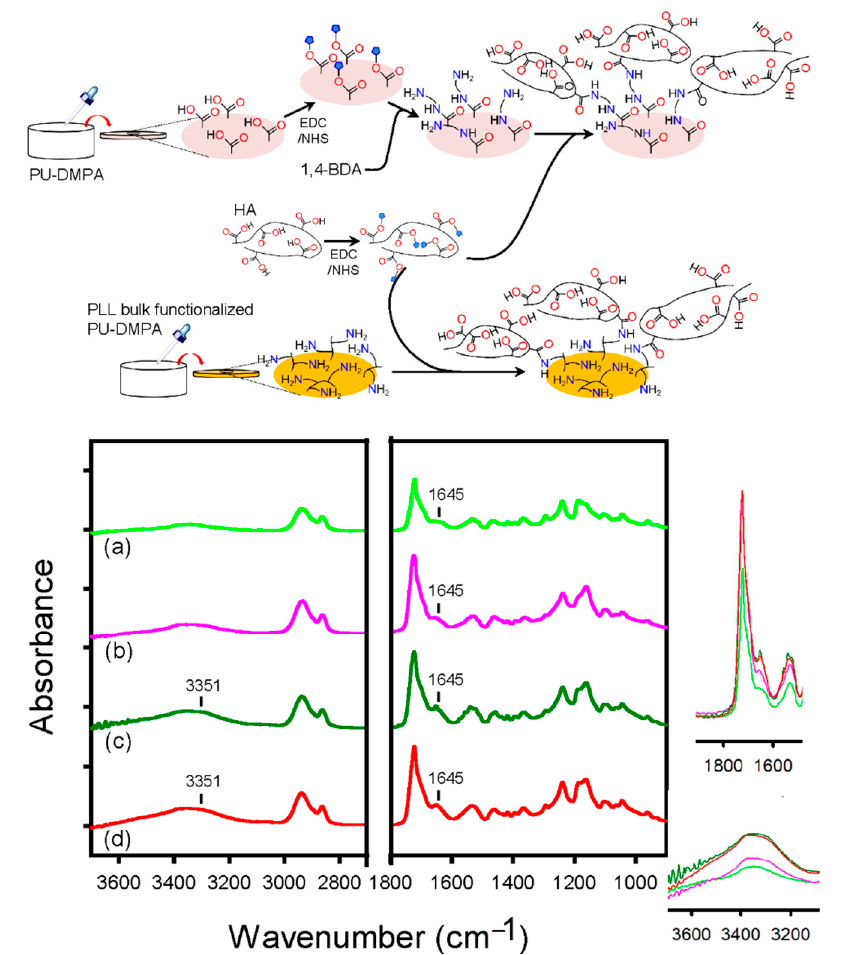
Figure 9. Top: schematic of the amino functionalization of the PU-DMPA cast film and bulk polymer solution by 1,4-BDA and PLL, respectively, followed by the incorporation of HA. Bottom: ATR-FTIR spectra of the BDA-modified PU-DMPA ( a ), the PLL-modified PU-DMPA ( b ), the HA-modified PU-DMPA-BDA ( c ), and the HA-modified PU-DMPA-PLL ( d ). The HA-modified surface of the PU-DMPA-BDA and the PU-DMPA-PLL films were subjected to platelet adhesion tests with the PU-DMPA, PU-DMPA-BDA, and PU-DMPA- PLL films serving as controls. A material that has antithrombotic ability might be applied in the development of blood contact devices. Figure 10 shows the SEM images of the mor- phology of platelets adhered on the five surfaces. SEM showed less platelet adhesion on the surface of the PU-DMPA-BDA-HA and the PU-DMPA-PLL-HA films. The attached platelets, if any, had round shapes. The PU-DMPA-PLL-HA membrane even had less platelet adhesion than the PU-DMPA-BDA-HA. The results may be attributed to more amino groups in PLL and hence more HA conjugation on the PU-DMPA-PLL. Despite the limited number of carboxyl groups in the PU-DMPA backbone, the number of available amino groups was multiplied with the use of PLL as a linker. Obvious platelet adhesion on the PU-DMPA-BDA and the PU-DMPA-PLL was noted possibly due to the positive charge of amino groups. Interestingly, the PU-DMPA surface also displayed only few ad- hered platelets, perhaps due to the negative charged of the carboxyl groups. Hong et al. also found reduced platelet adhesion on the surface of their poly(ester urethane) bearing carboxyl groups [18]. This contradicts the finding in an earlier study; however, note that hydroxytelechelic polybutadiene was used for soft segments in said study [38].